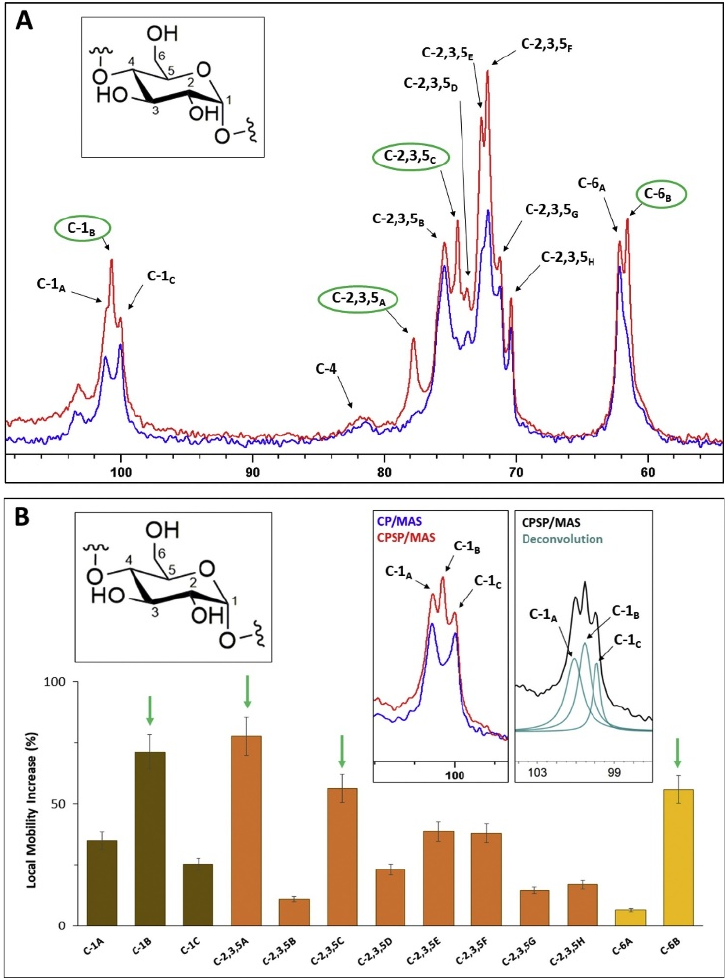
Figure 5. CP and CPSP MAS NMR spectra of normal maize hydrogels: ( A ) an overlay of both spectra with the assignment of peaks with increased local mobility, ( B ) an estimate of the local mobility level for all detected carbon atoms. The insert shows the deconvoluted peak and assignments. Adapted with permission from Ref. [99]. Copyright 2020,